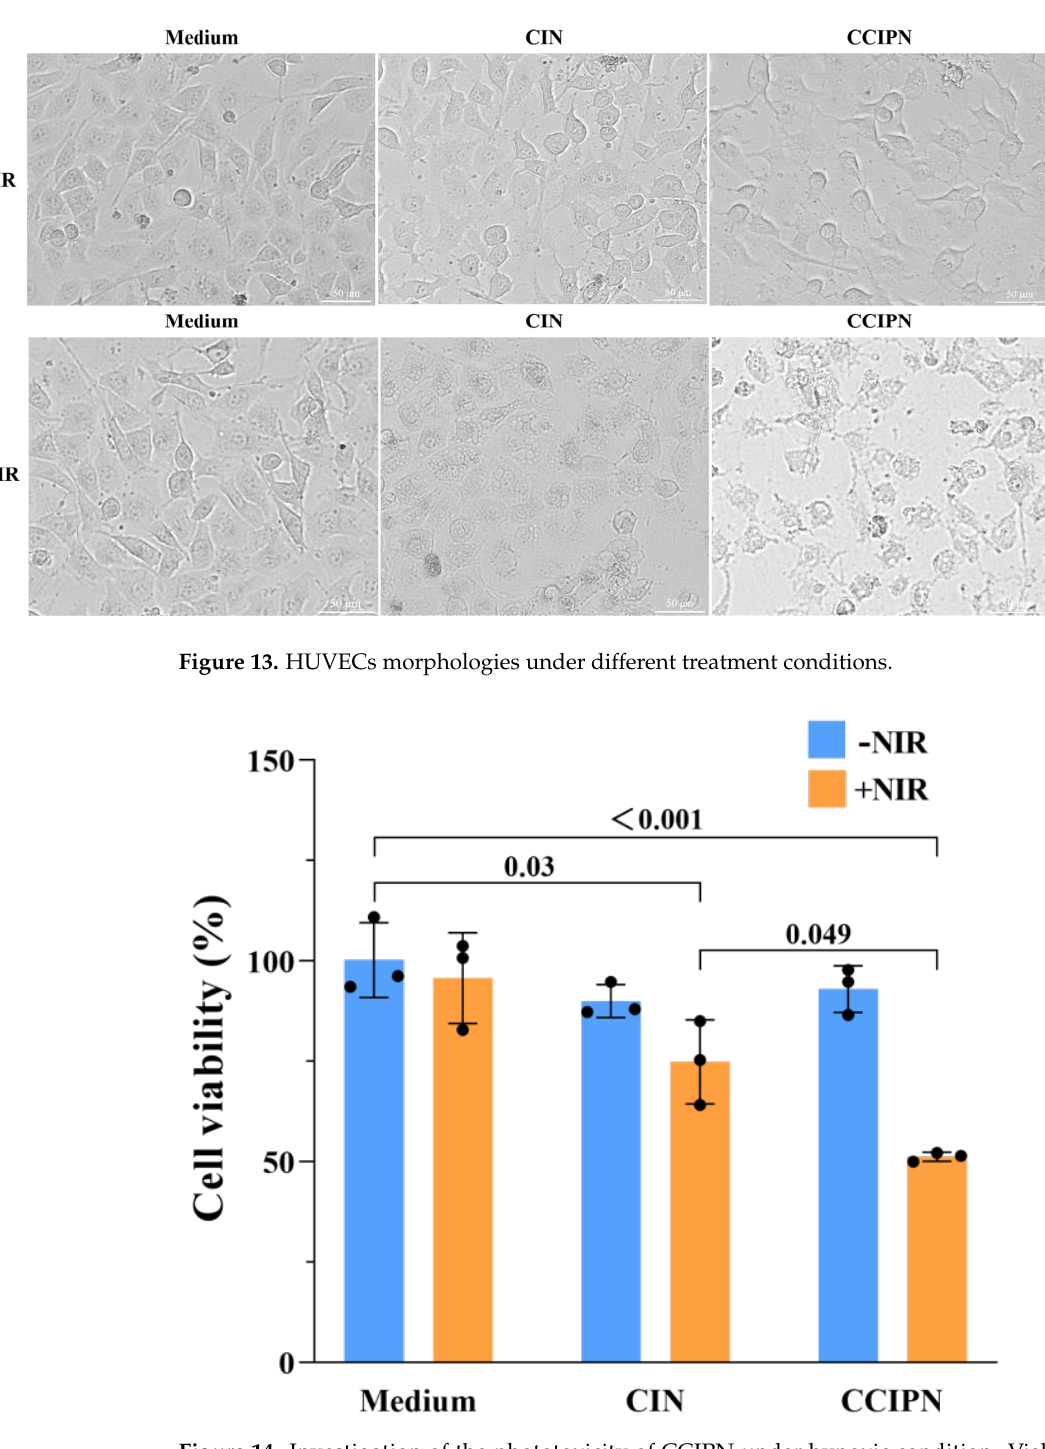
Figure 15. PC-3 cell morphologies after receiving different treatments in hypoxic condition. 3.9. Intracellular ROS Production by CCIPN After determining the ability of CCIPN to kill cells in response to light stimulation, we further explored the mechanism underlying the phototoxicity in terms of intracellular ROS production. The intracellular ROS generated by CCIPN and CIN at the same IR780 concentration with or without NIR irradiation was quantified utilizing a fluorogenic probe DCFH-DA, with serum-free medium serving as a control. After 785 nm laser irra- diation, the DU145 prostate cancer cells incubated with CCIPN showed clearly higher flu- orescence intensity compared with those incubated with CIN (1.51-fold, Figure 16a). This demonstrated that more ROS was generated by the CCIPN under laser irradiation. Con- sistently, tests on another prostate cancer cell line, PC-3, showed that the fluorescence in- tensity of the CCIPN + NIR group was clearly higher than that of the CIN + NIR group (1.93 fold, Figure 16b), which indicated the higher efficiency of CCIPN in generating cy- totoxic ROS upon light stimulation in comparison with CIN. The results here are in agree- ment with other research using catalase [43] or perfluorocarbon [44] to increase the PDT